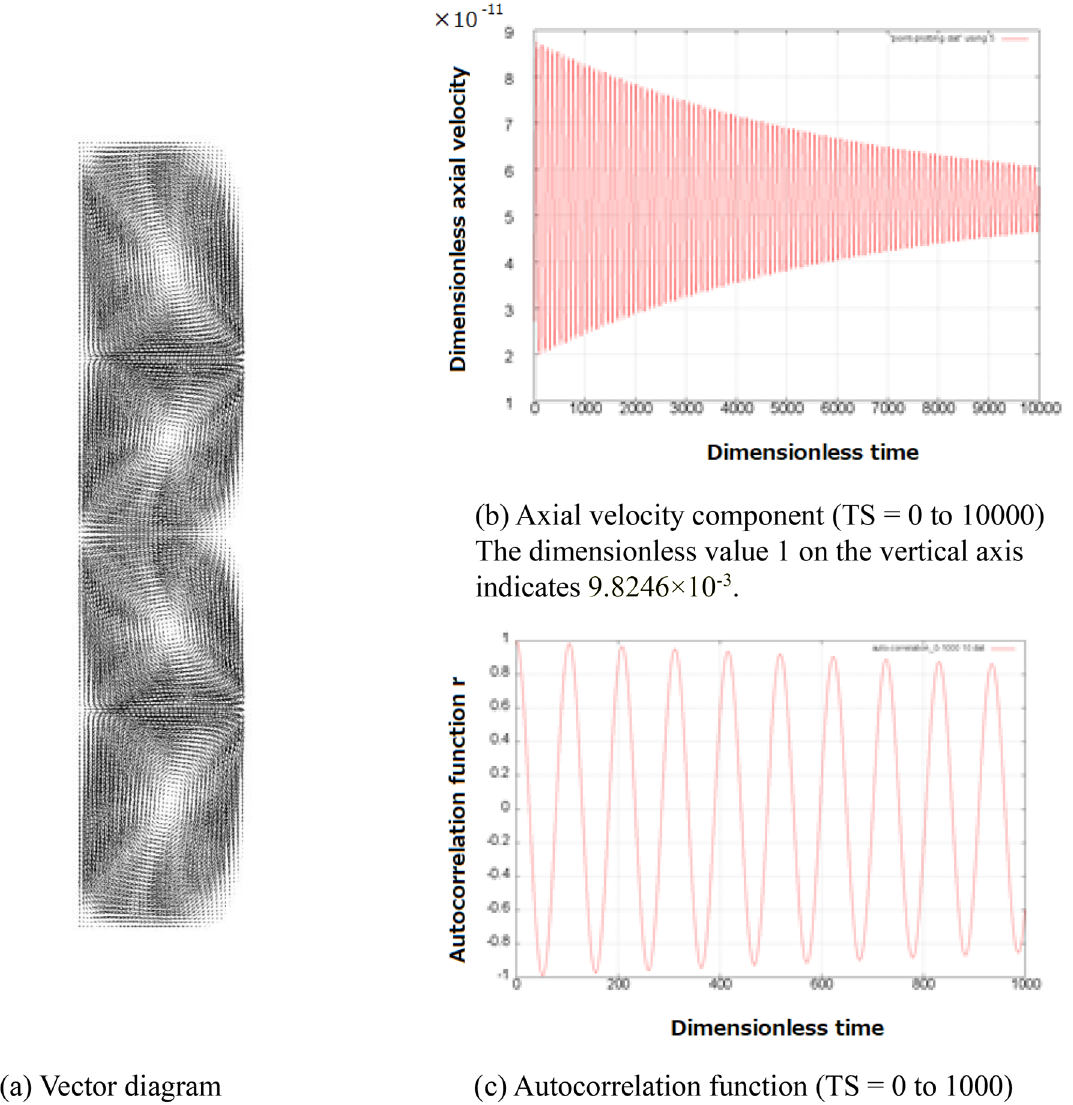
Fig. 7 Numerical results at Re = 1350, Γ =